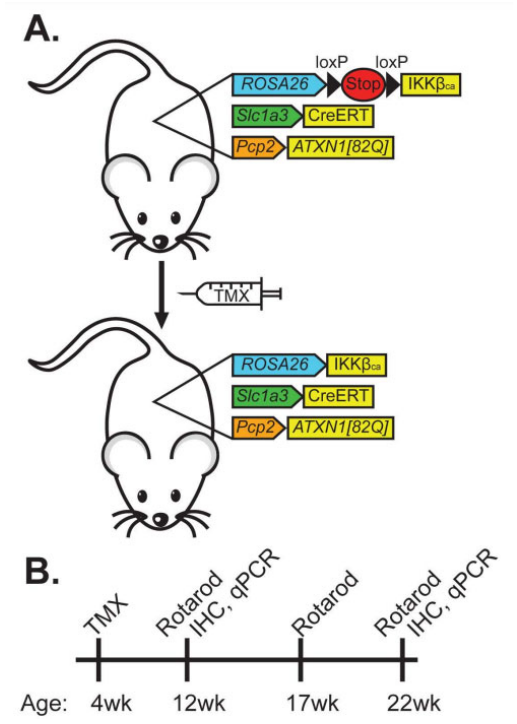
Figure 1. Generation of the novel SCA1 transgenic mouse line to induce astroglial NF ‐κ B signaling in a TMX ‐ dependent manner . ( A ) Schematics illustrate that intraperitoneal injection tamoxifen (TMX) activates Cre ‐ recombinase (CreERT) expressed under astrocyte ‐ specific Slc1a3 promoter, allowing for removal of loxP enclosed STOP cassette and expression of constitutively active IKK β (IKK β CA) expression under control of the endogenous ROSA26 promoter. Animals also express mutant ATXN1 [82Q] under Purkinje cell ‐ specific promoter Pcp2 . ( B ) Timeline schematic showing animal age (bottom) and experiment (top). Mice were injected with TMX or oil control at four weeks of age, and rotarod was performed at 12, 17, and 22 weeks of age. Animals were sacrificed after rotarod experiments occurring at 12 or 22 weeks of age. Tissue was analyzed by immunohistochemistry (IHC) or RT ‐ qPCR.